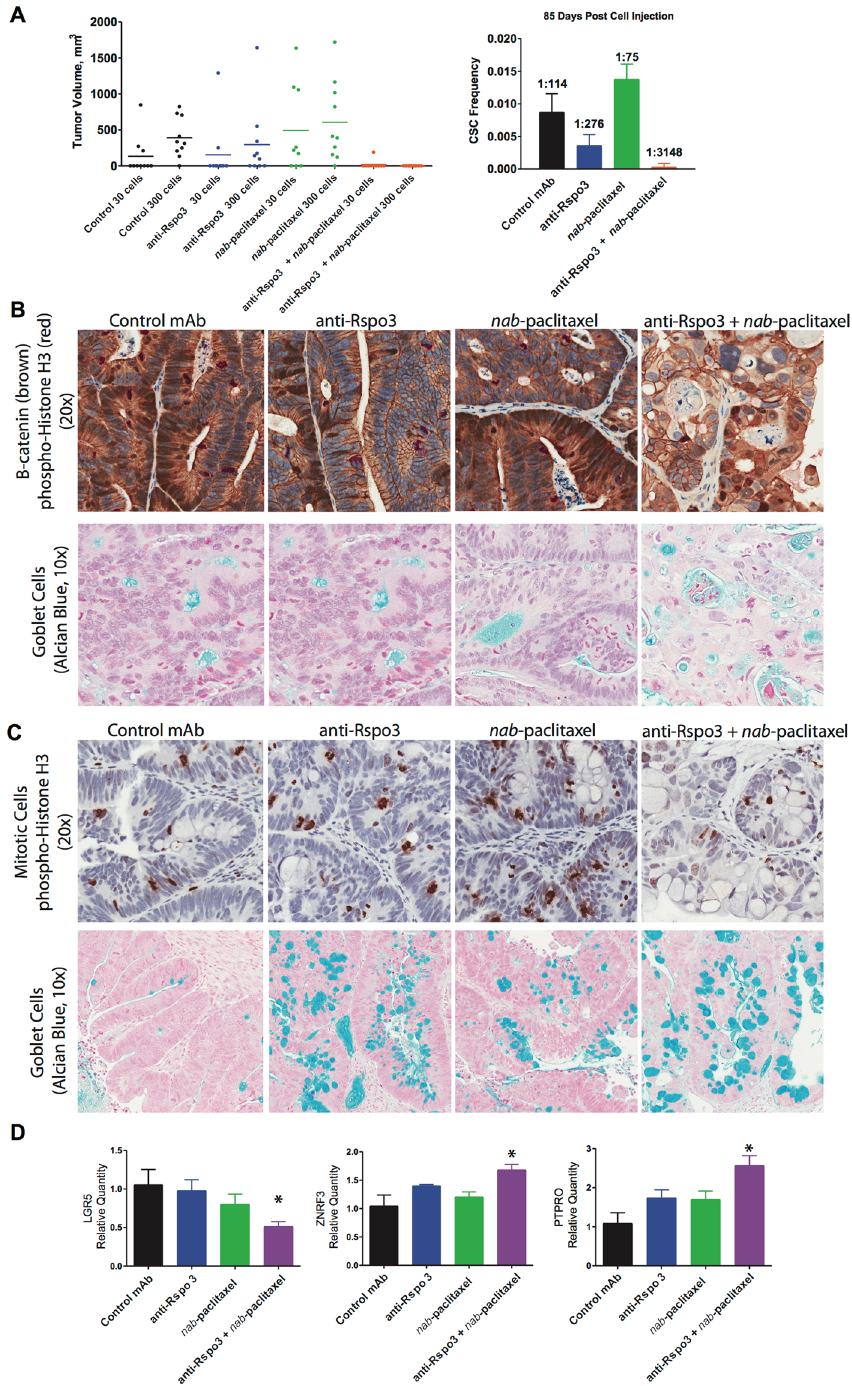
Figure 4. RSPO3-taxane regimen reduces CSC self-renewal properties by reducing β -catenin transduction and potentiating paclitaxel mediated mitotic blockade. ( A ) Limiting dose assay in OMP-C8 tumor model, from Fig. 3. The combination of anti-Rspo3 (25 mpk) on day 1 and nab -paclitaxel (30 mpk) on day 3 and day 10 in three-two week cycles reduces the cancer stem cell frequency as compared to nab -paclitaxel, by 40-fold. Tumors were serially passaged on day 38, seven days after the last treatment cycle, at a cell dose of 30 or 300 cells into recipient mice, 10 mice per cell dose and 20 mice per treatment group. On day 85 of the LDA, tumor take was determined and the CSC frequency was calculated. ( B ) Anti-Rspo3 + nab -paclitaxel reduced nuclear β -catenin expression, disrupted mitosis, and promoted the expansion of differentiated mucin producing goblet cells. OMP-C8 tumors were assayed for β -catenin expression (brown) and mitotic activity (red, PHH3) with nuclear counterstain (blue), 20x magnification. Goblet cells were detected by Alcian Blue counterstain (blue) with nuclei in purple, 10x magnification. ( C ) Nab -paclitaxel expands for mitotic cells while combination with anti-Rspo3 promotes for endoreduplication and the selection of differentiated goblet cells. From